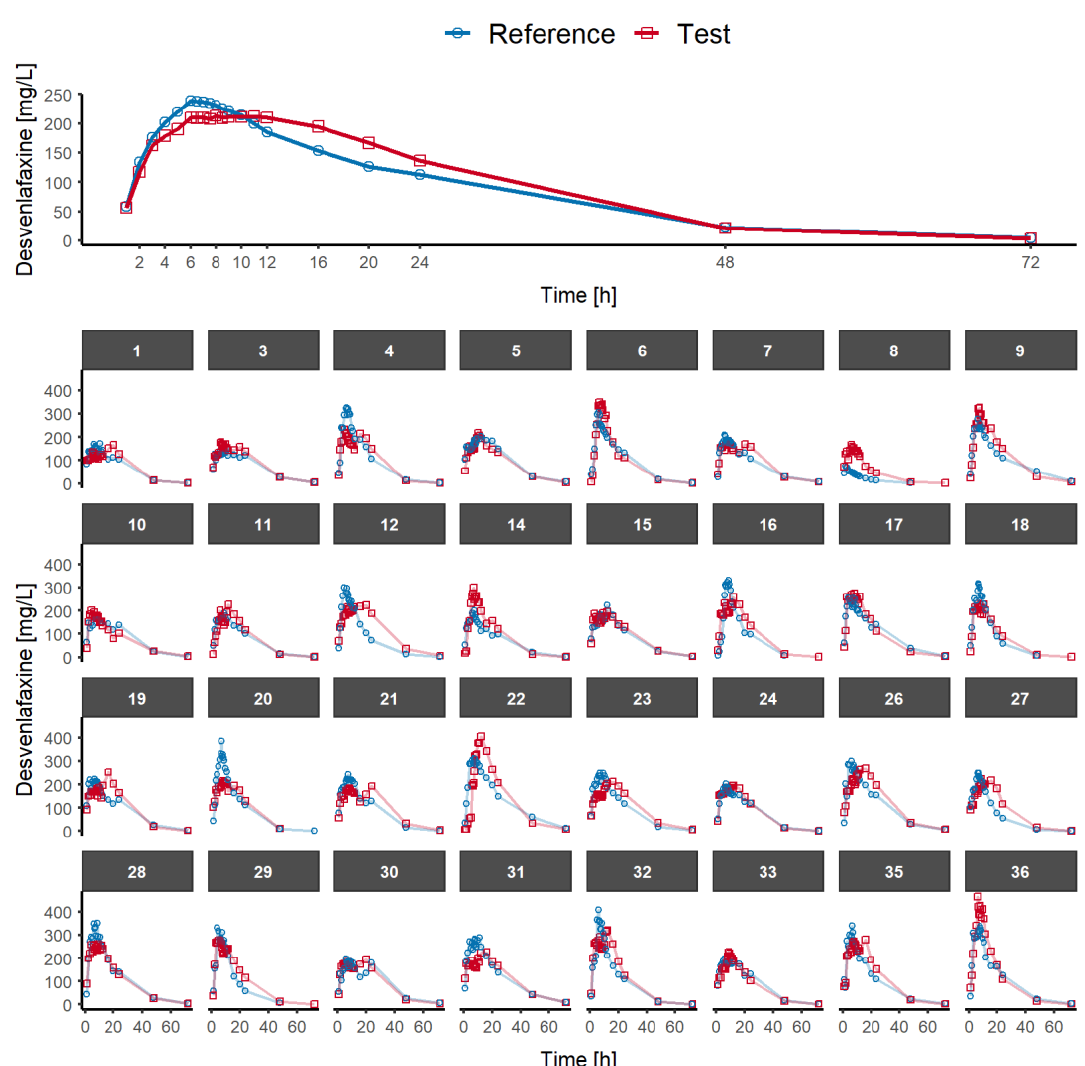
Figure 1. Average and individual observed plasma concentrations of desvenlafaxine vs. time after the administration of desvenlafaxine 100 mg prolonged-release tablets as a single dose in fasted conditions in 32 healthy volunteers. Blue circles and red squares represent the experimental desvenlafaxine observations of reference and the test formulations, respectively. Table 2. Bioequivalence evaluation of C τ and different pAUCs of desvenlafaxine 100 mg prolonged- release tablets after the administration of a single dose under fasting conditions in 32 healthy